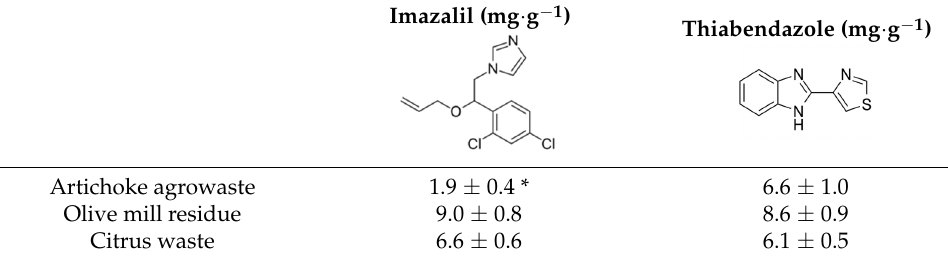
Table 2. Sorption capacity ( q e ) of the selected agrifood wastes.